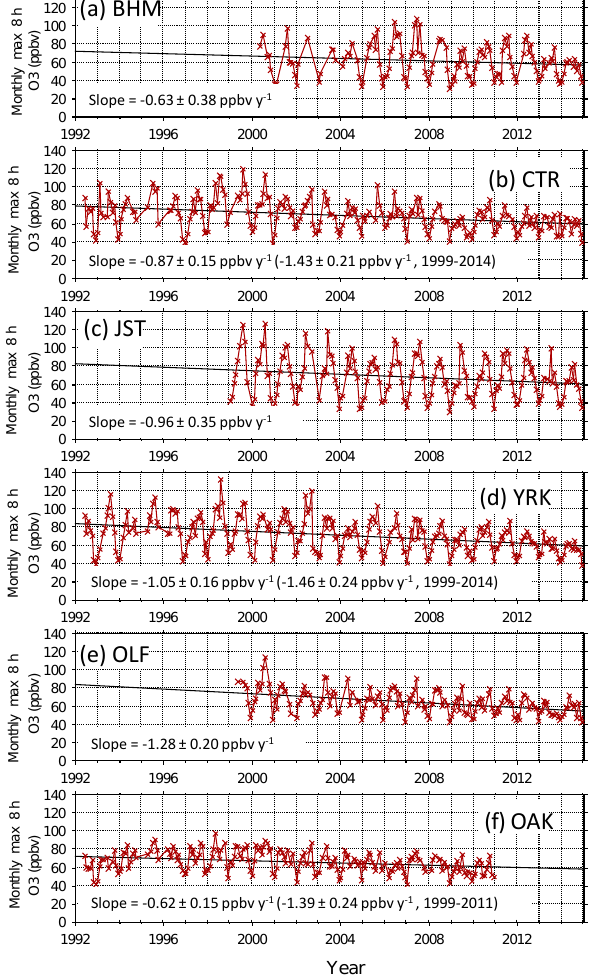
Figure 3. Monthly maxima of daily peak 8h average O 3 mixing ratios. All monthly maxima are determined from 24 or more days with 18 or more sampling hours per day. PNS and GFP (not shown) exhibit trends of − 1.64 ± 0.45 and − 0.60 ± 0.32ppbvyr − 1 , respec- tively. Trends are statistically significant ( p < 0.01) at CTR, JST, OAK, OLF, PNS, and